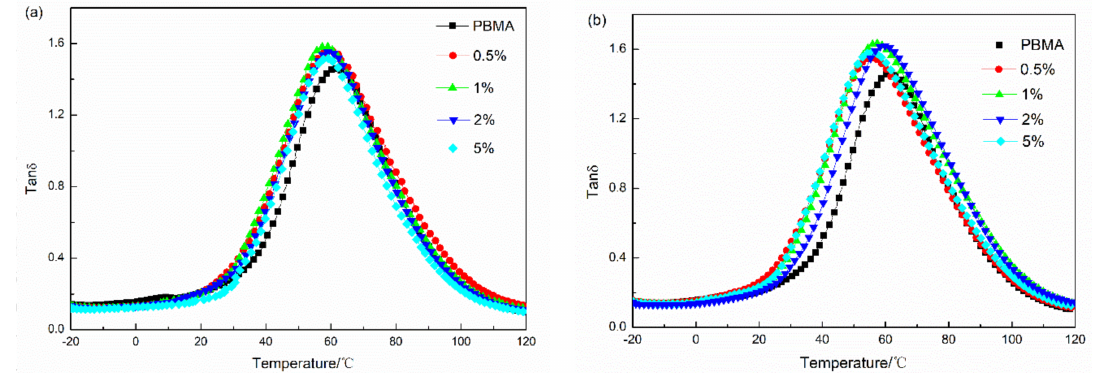
Figure 5. Temperature dependence spectra of tan δ of PBMA with different particles and different mass fraction at 1 Hz. ( a ) Fe 3 O 4 ; ( b ) α -Fe 2 O 3